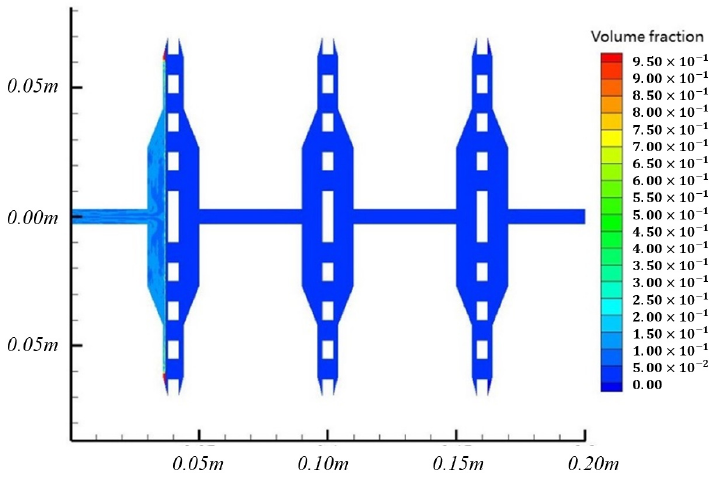
Figure 9. Four-micrometer particle final volume fraction cloud image.